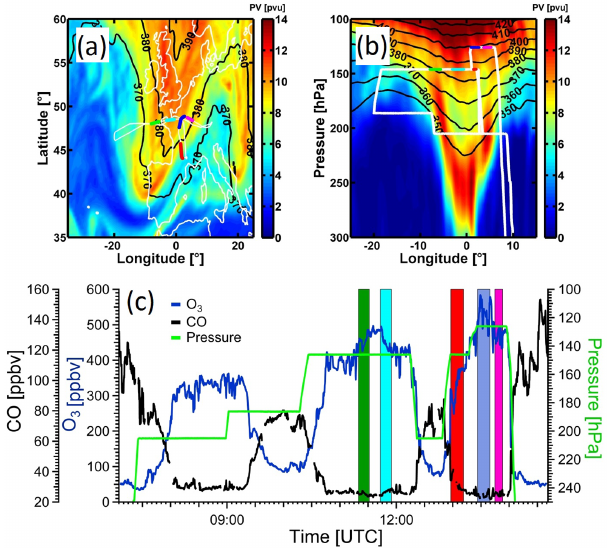
Figure 2. TACTS flight 2 on 30 August 2012. (a) ECMWF data (15:00UTC) at 150hPa of potential vorticity (colour) and potential temperature (black contour lines). The thick white line is the flight path of TACTS flight 2. (b) Horizontal cross section of ECMWF potential vorticity data along 48.5 ◦ N. Different colours in (a) and (b) indicate flight legs with measured mixing lines (see Sect. 3). (c) Time series of CO (black), O 3 (blue) and pressure (green). Data points which form mixing lines are coloured according to panel (a) and (b) . The total uncertainty of CO and O 3 is mostly within the line thickness and therefore not shown (for individual error bars see Fig. 3 and